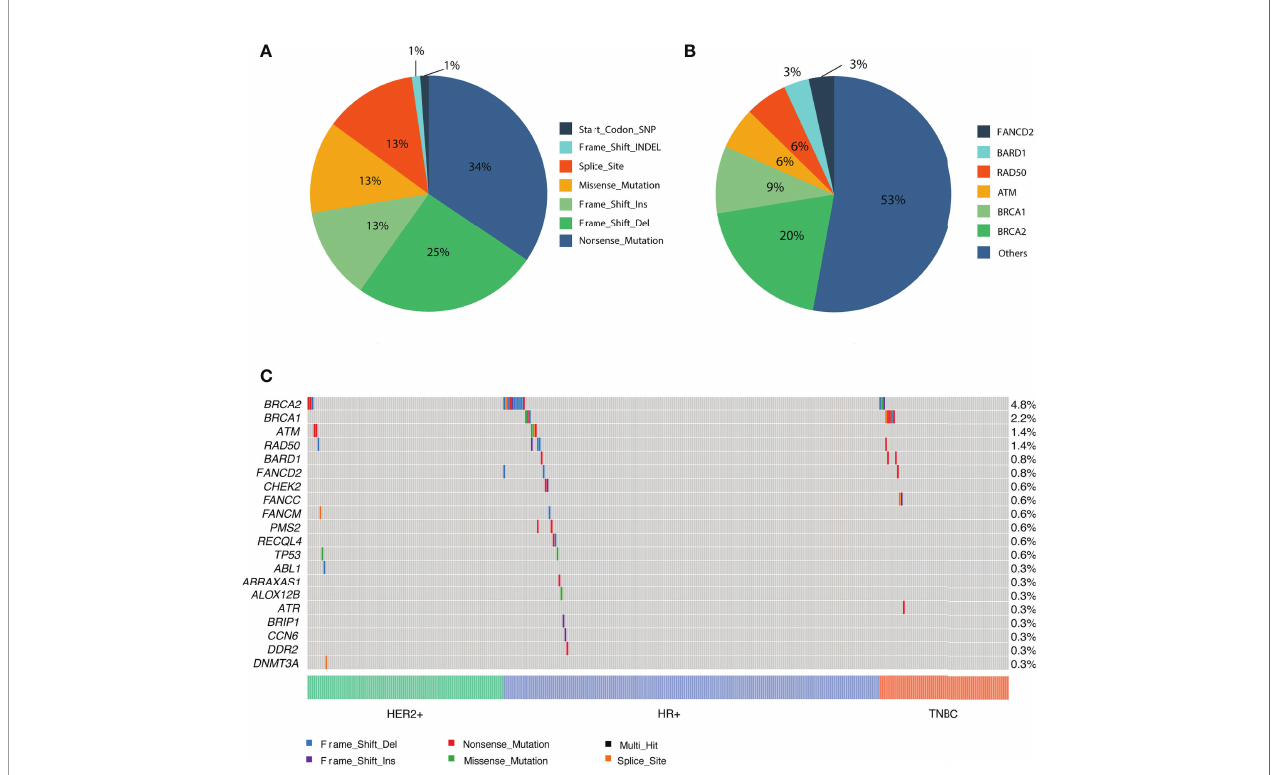
FIGURE 3 | Overview of the identi fi ed pathogenic variants by PredicineATLAS panel. (A) Pie chart representing the variant classi fi cation of the pathogenic mutations. (B) Pie chart representing the overall distribution of the 87 detected pathogenic genes. (C) Heatmap representation of the top 20 detected pathogenic mutations across cancer subtype